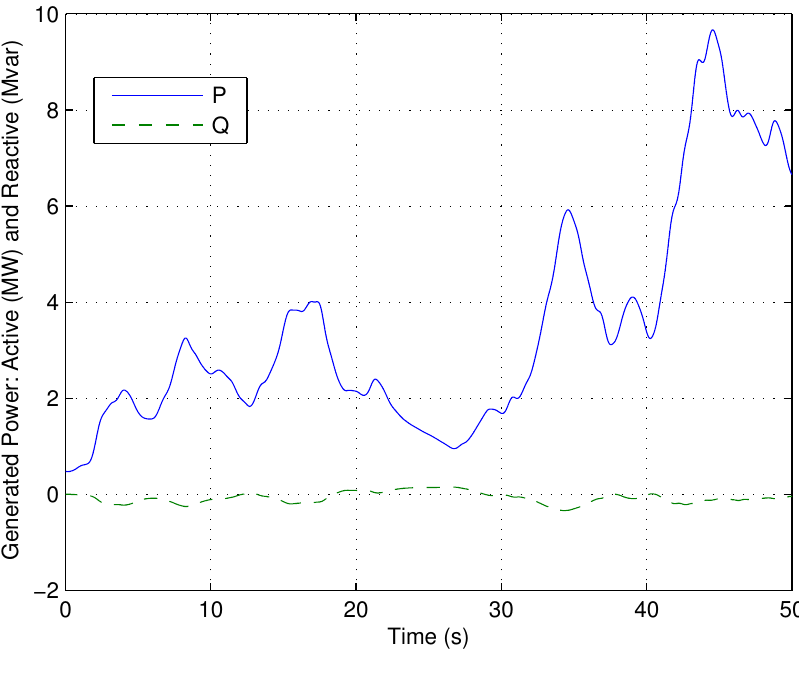
Figure 6. Generated active power.